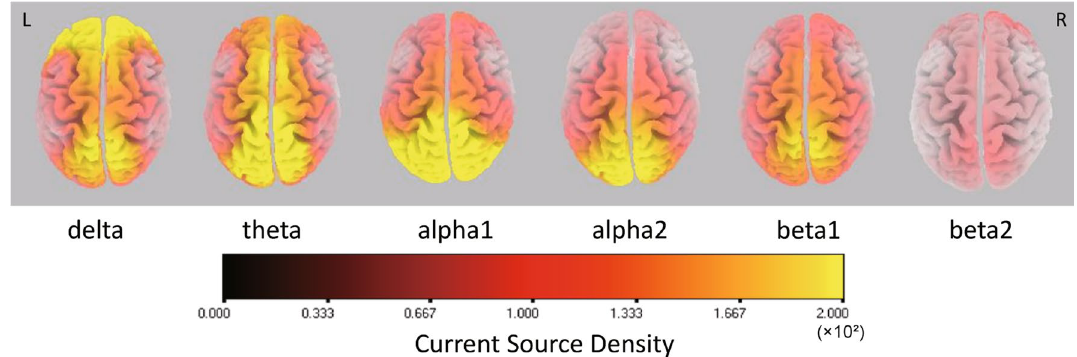
Figure 2. Averaged eLORETA source current density in each frequency band in patients with left frontal gliomas. The color map indicates the current source density (CSD) from black at 0 to yellow at